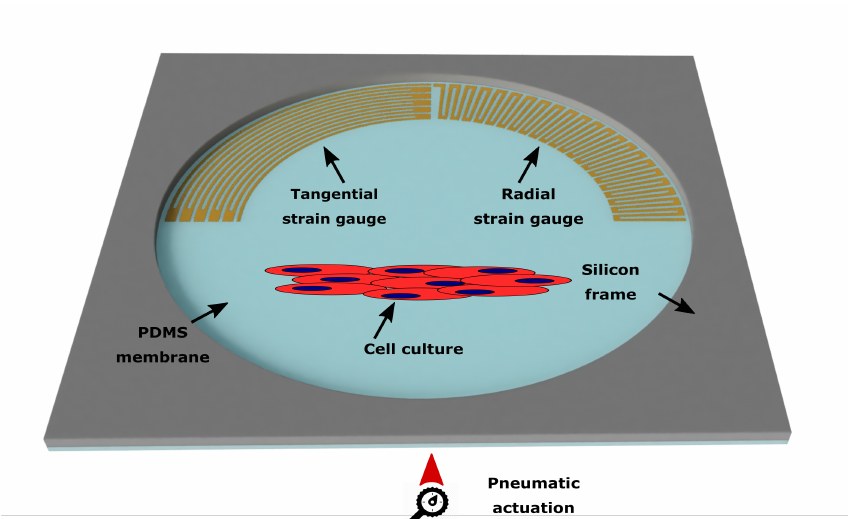
Figure 1. The architecture of the device investigated for stress sensing in a microfabricated PDMS-based OOC platform: Tangential and radial microstructures (strain gauges) on PDMS membranes suspended from a holding silicon frame. The membrane is pneumatically actuated to provide the stretching to a cell culture on its